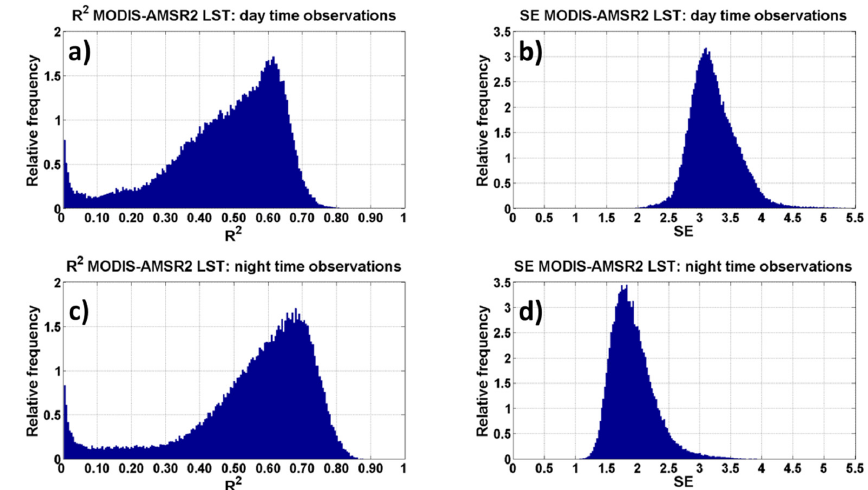
Figure 3. Histograms of the anomalies that show the agreement between the Land Surface Temperature products from MODIS and AMSR2 expressed in R 2 ( a ) for day time observations, SE ( b ) for day time observations, R 2 ( c ) for night time observations and SE ( d ) for night time observations.